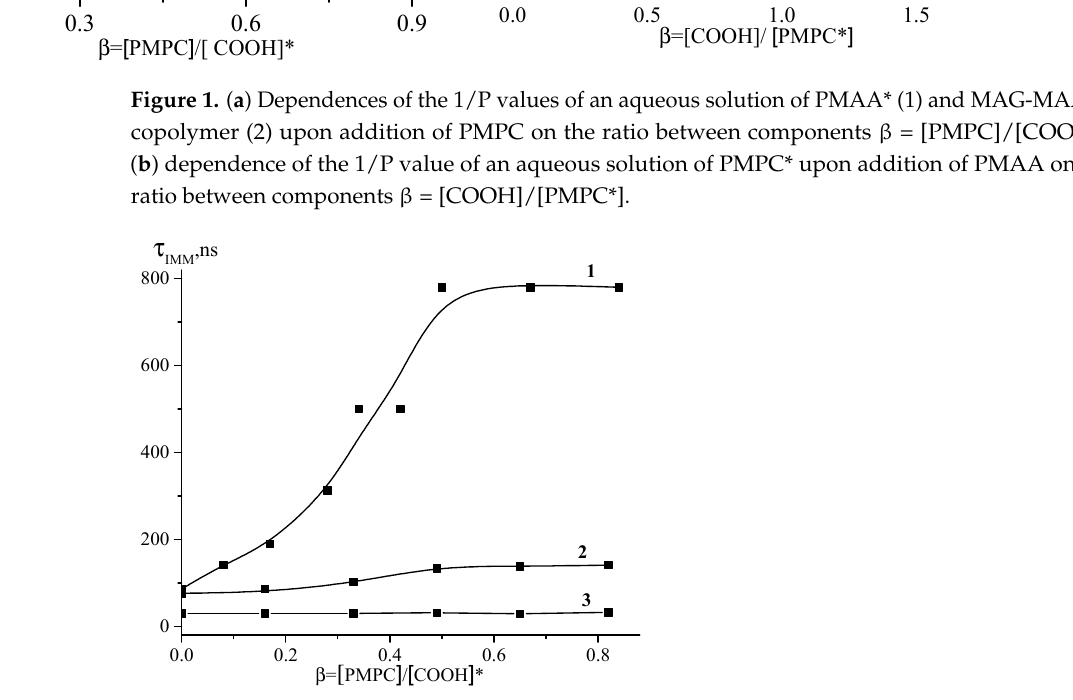
Figure 2. Dependences of τ IMM of PMAA* (1), copolymer ( МА G- МА A 70 )* (2), copolymer ( МА G- МА A30)* (3) on the ratio β = [PMPC]/[ СООН ].